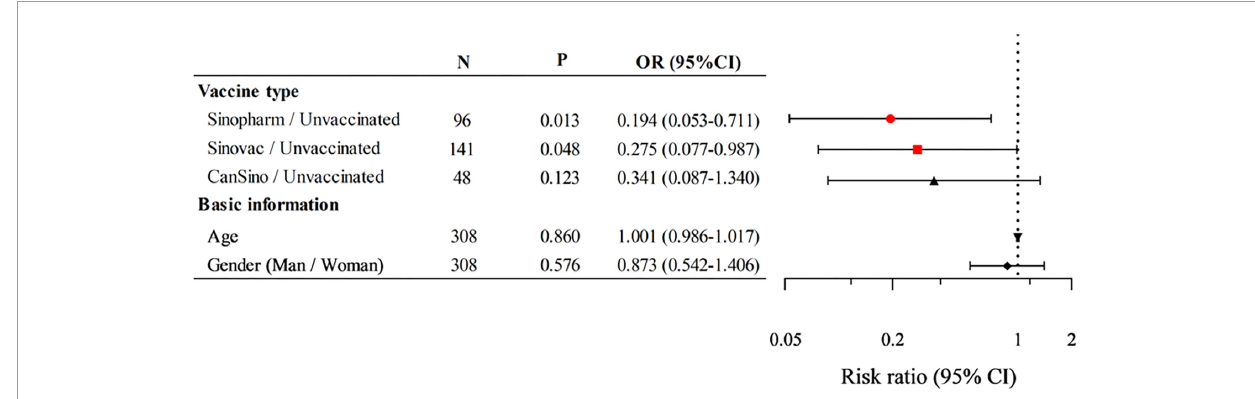
FIGURE2 Logistic regression analysis of the risk and protective factors on the coronavirus disease 2019 (COVID-19) disease severity. P < 0.05 were statistically significant. N , total number of cases; OR, odds ratio; CI, confidence interval.